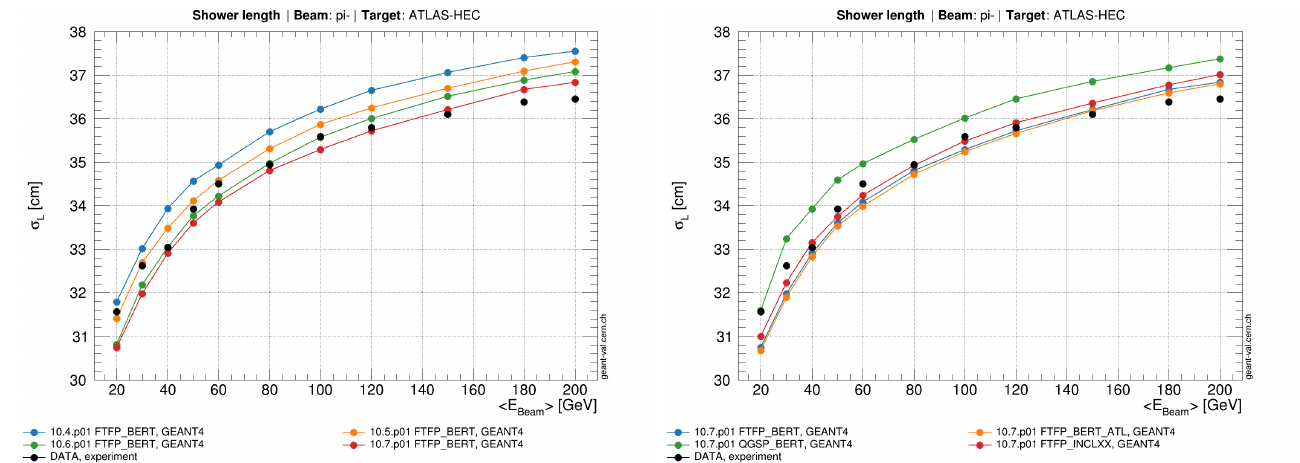
Figure 5. Left : σ L comparison of the Geant4 FTFP_BERT PL prediction for recent releases (2017–2020) with experimental data. Right : Comparison of several PL predictions from Geant4 10.7.p01 for the same